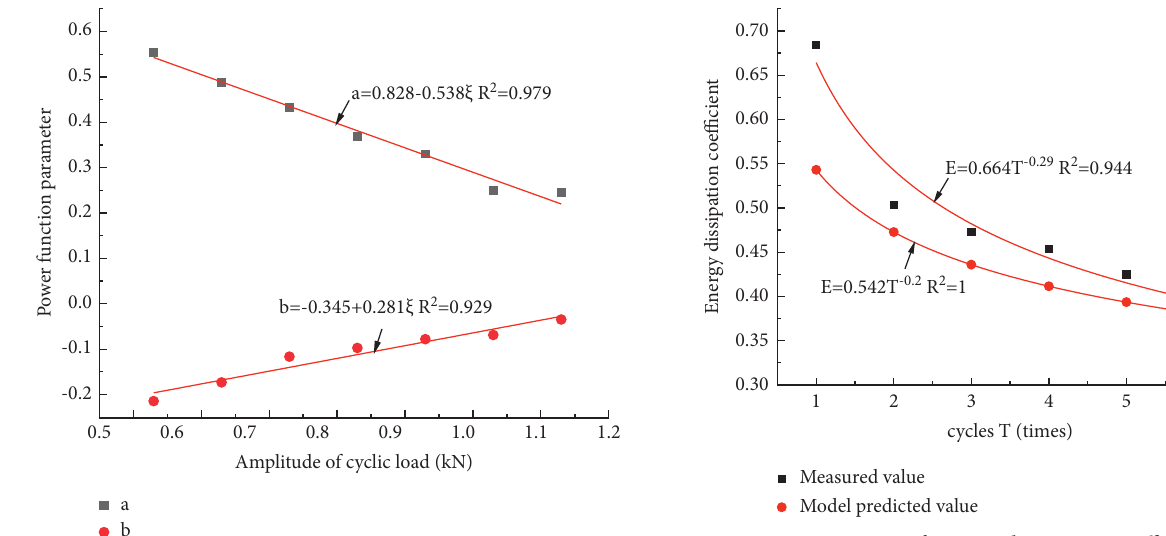
Figure 20: Comparison of energy dissipation coefficient model prediction and measured measurement at ± 0.53kN for